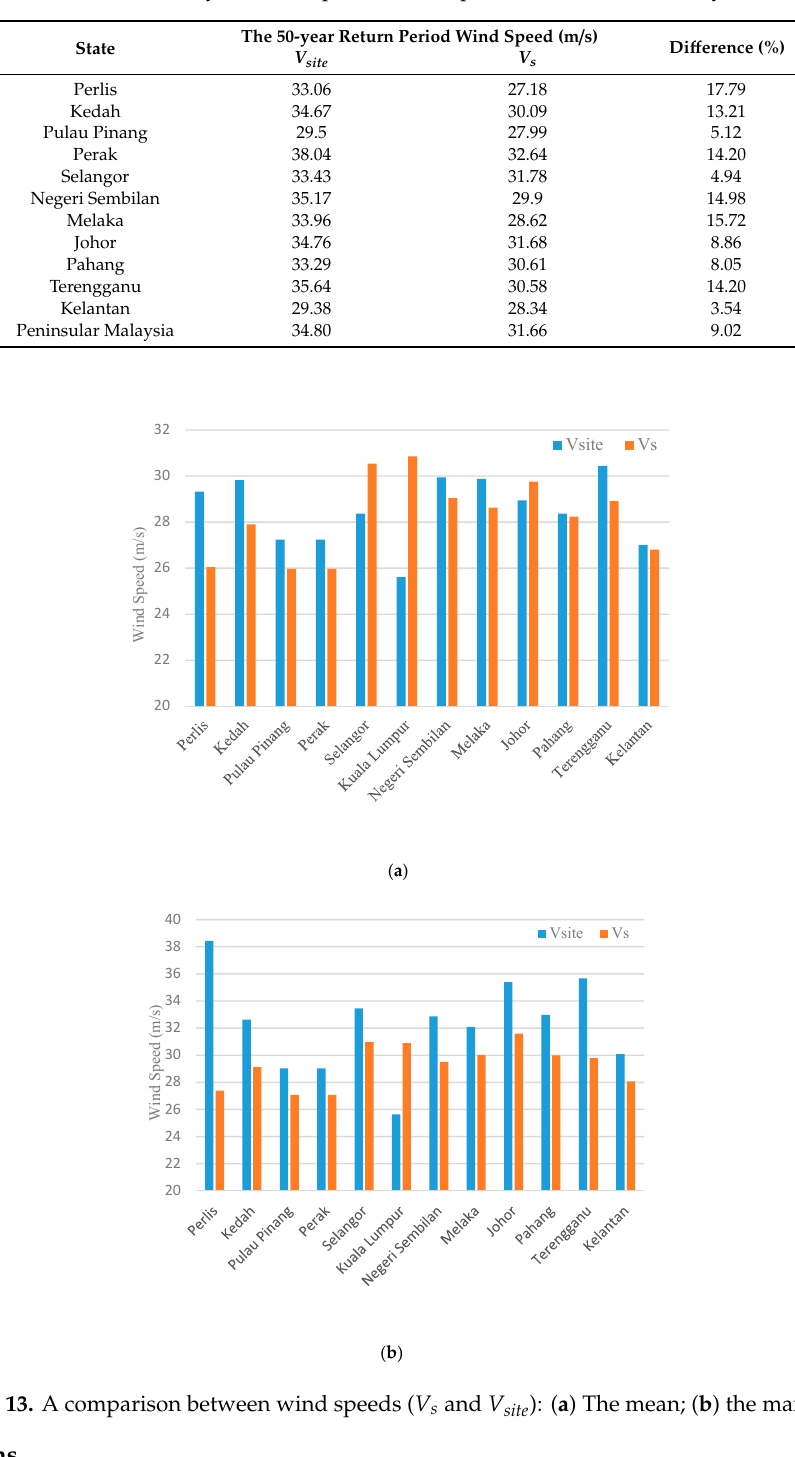
Table 8. The 50-year return period wind speeds of Peninsular Malaysia.